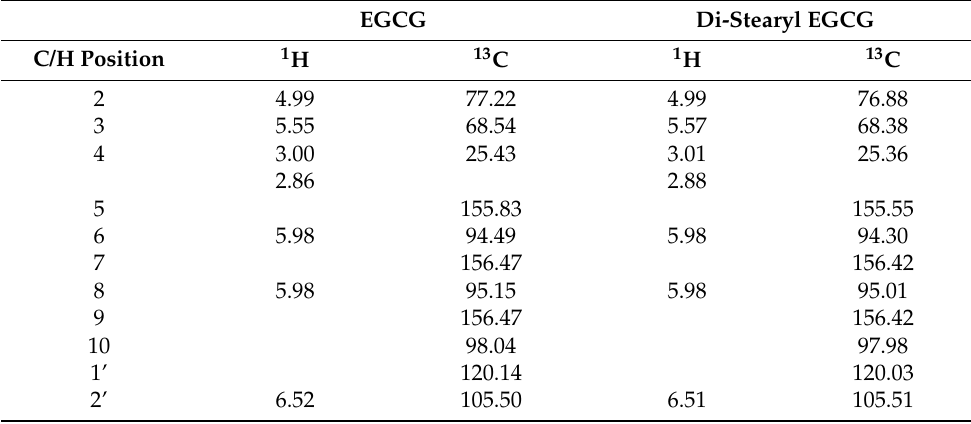
Table 1. 1 H and 13 C Chemical Shifts ( δ ) of EGCG and Di-stearyl